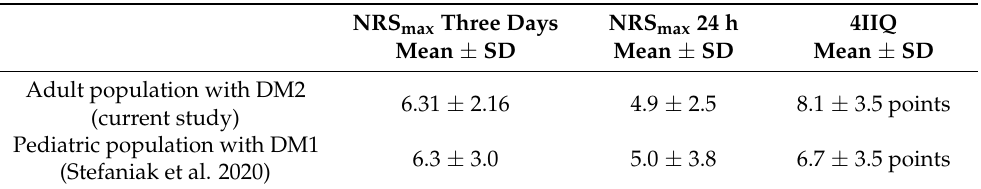
Table 6. Itch intensity in adult population with type 2 diabetes mellitus compared to pediatric population with type I diabetes mellitus